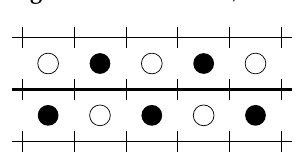
Figure 24. An obstacle, abbrev.